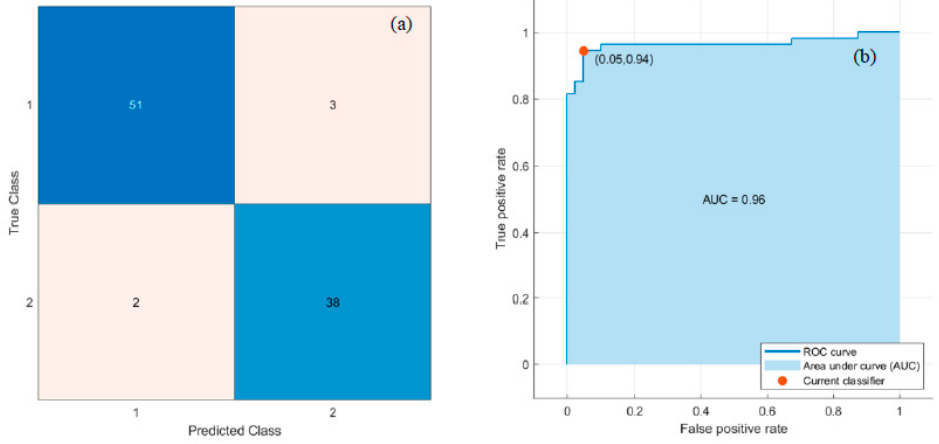
Figure 12. Second best results with MLP classifier: ( a ) Confusion matrix, and ( b ) ROC curve.